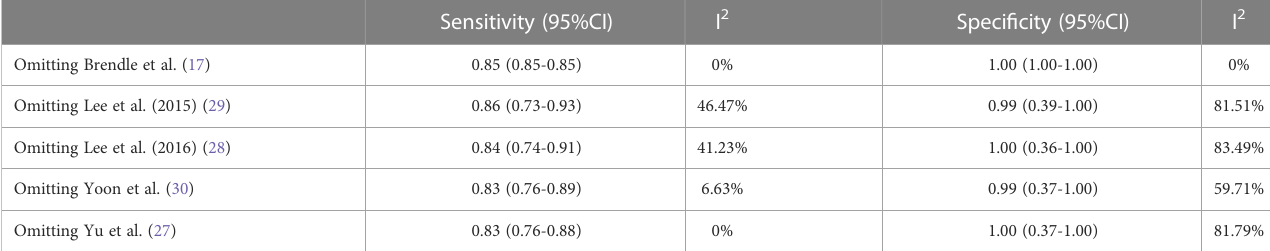
TABLE 6 Sensitivity analysis of 18F-FDG PET/MRI for colorectal liver